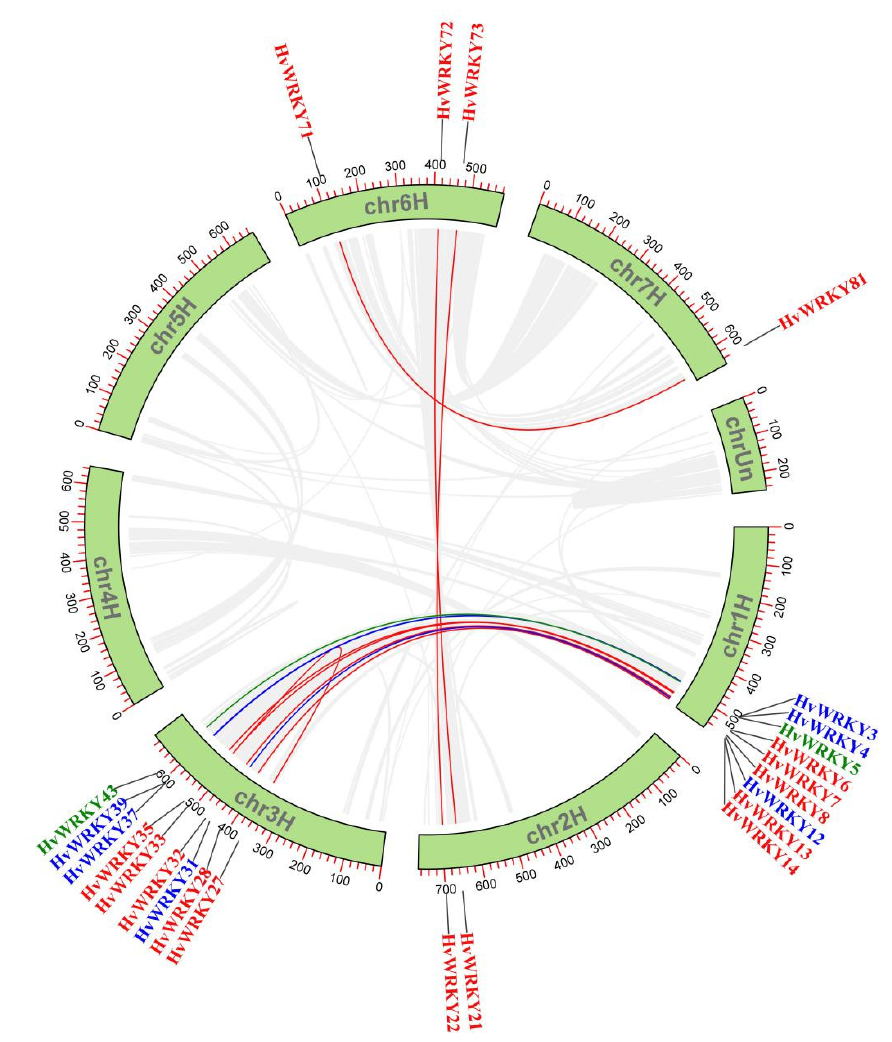
Figure 1. The segmental duplication of WRKY family in barley. The Circos map drawn by TBtools shows the position relationship of 12 pairs of segmental duplication gene pairs detected in barley genome. The scale outside the chromosome represents physical position (Mb). The green font is group Ⅰ WRKY, red is group Ⅱ , and blue is group Ⅲ .